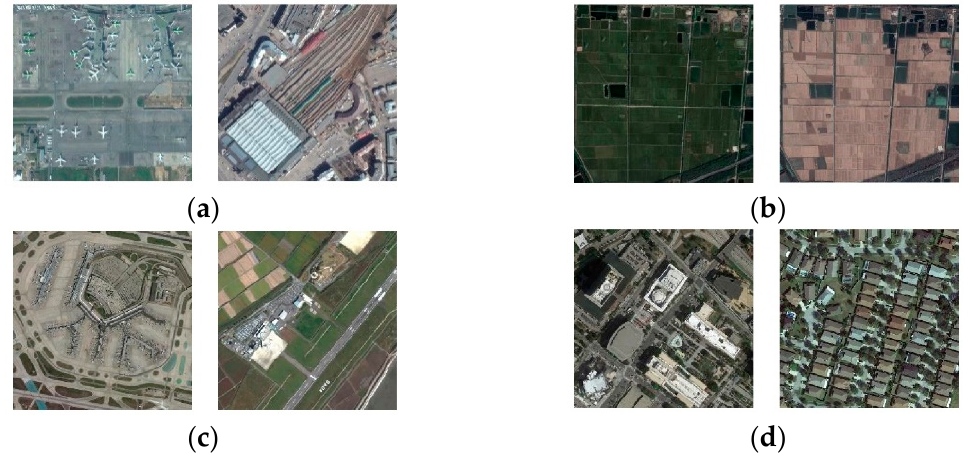
Figure 1. Image characteristics of geographic scenes in HSR remote sensing: ( a ) reflects the diversity of the ground objects in the geographic scene; ( b ) reflects the diversity of imaging conditions of HSR remote sensing images; ( c ) reflects the differences in the types of ground objects in the same category of geographic scenes; ( d ) reflects the similarity in the types of ground objects in different categories of geographic scenes.